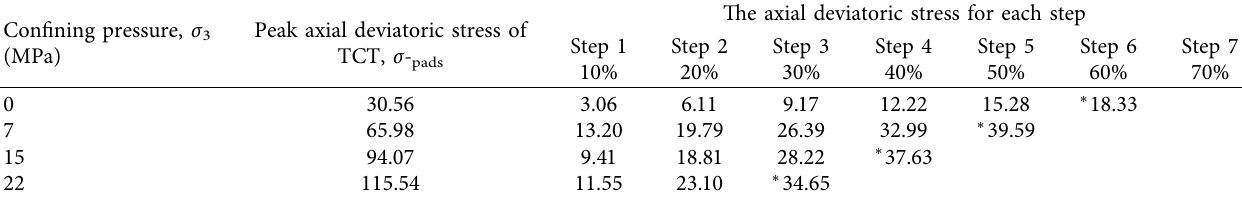
Table 3: The specific creep test plan under different confining